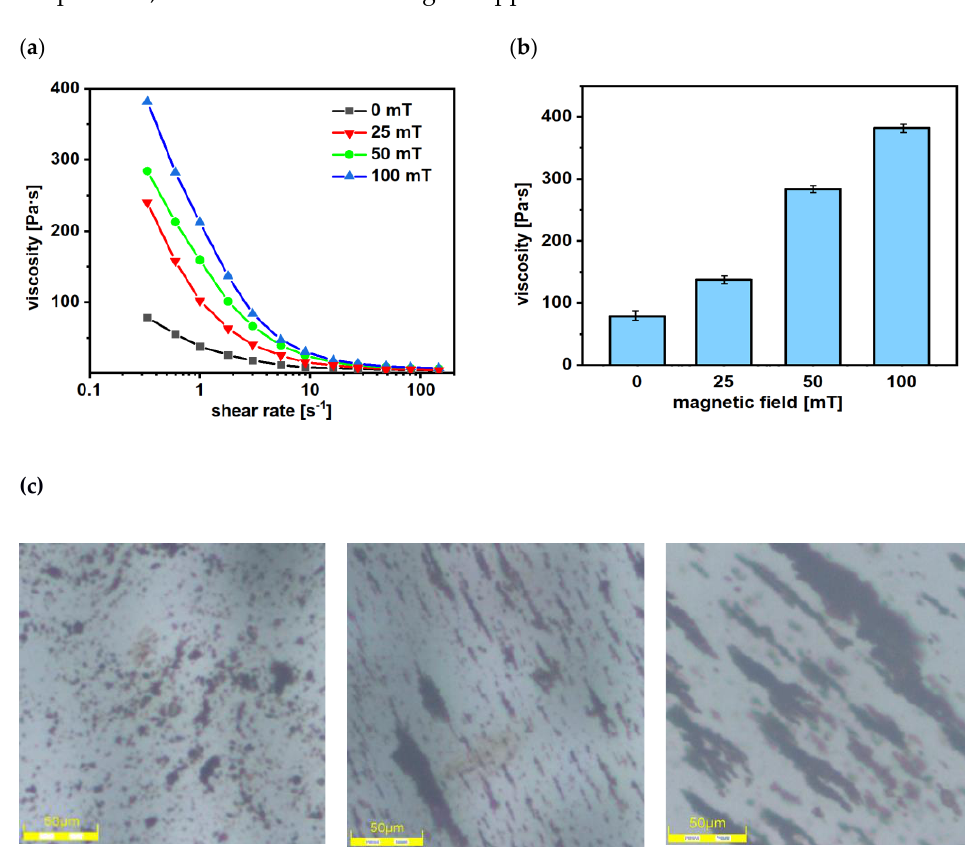
Figure 8. The change in the MRF’s viscosity in the function of ( a ) shear rate, ( b ) amplitude of magnetic field at a shear rate 0.3 s −1 (0, 25, 50 provided by coils, and 100 mT provided by magnets), and (c) optical microscope images of the MRF without magnetic field ( left ), with 25 mT fields ( middle ), and 50 mT ( right ).